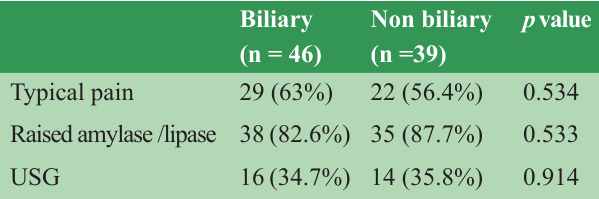
Table 4: Diagnostic criteria of AP